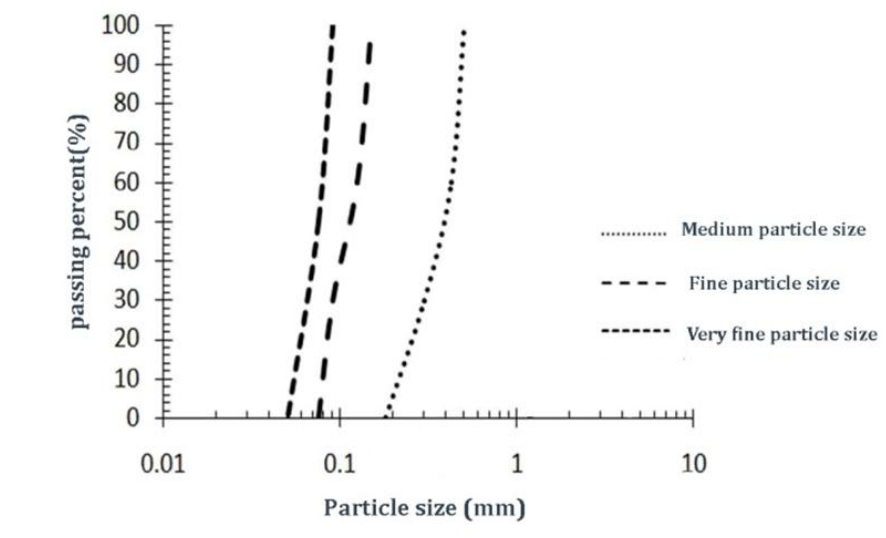
Fig. 1. Particle size distribution of the used sand